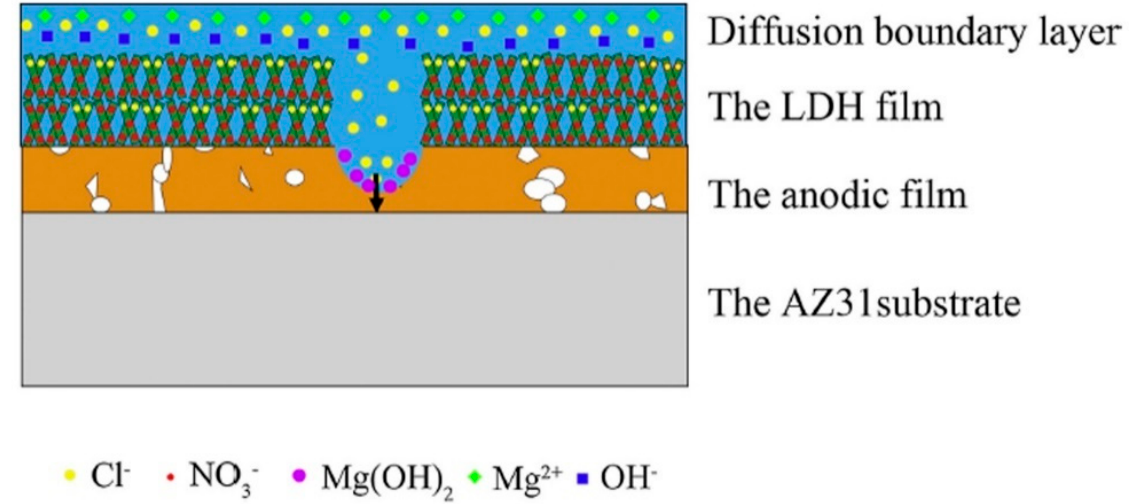
Figure 4. The proposed corrosion protection mode for the LDH/anodic film composite. Reprinted with permission from ref. [63]. Copyright 2018 Elsevier.